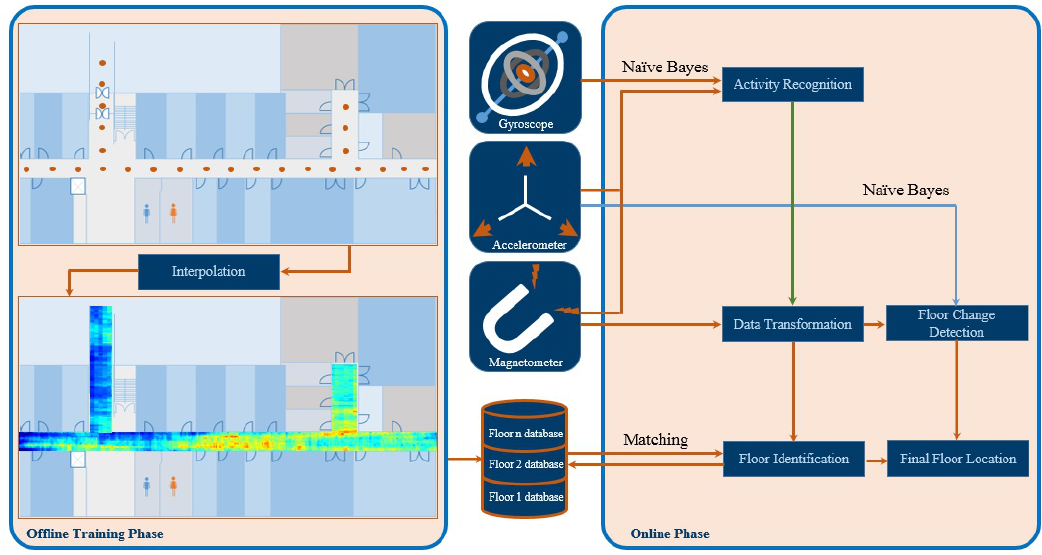
Figure 6. The block diagram of the proposed system.